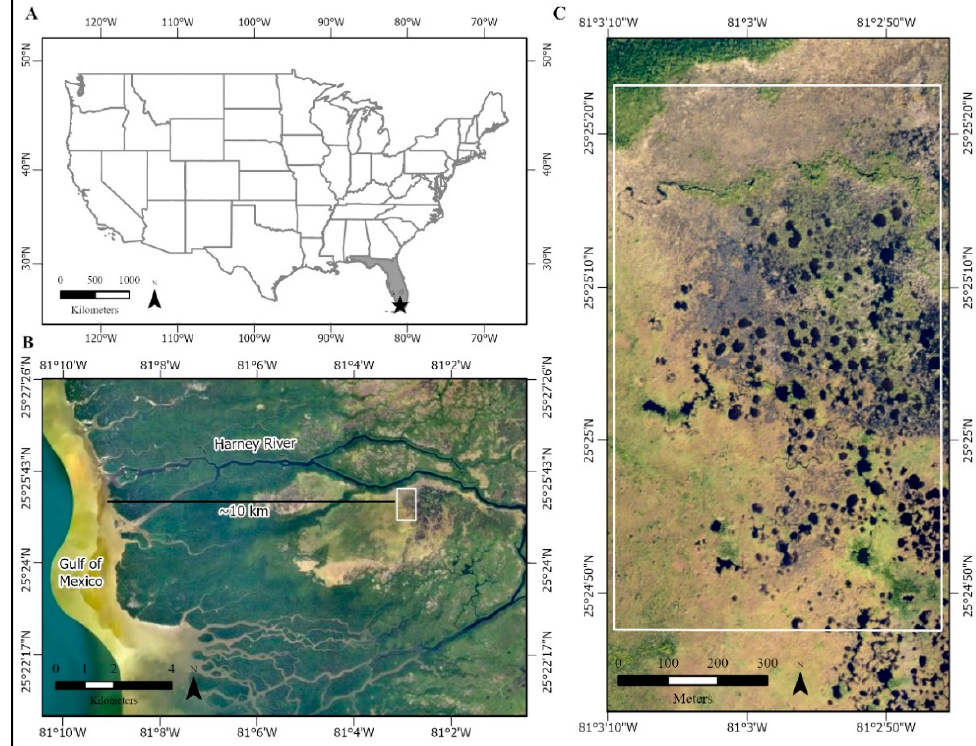
Figure 2. Overview of study area indicating the location of ( A ) the study area (black star) within the state of Florida (grey) in the United States; ( B ) the study area (white rectangle) and its position relative to the southwest coast of Florida with the distance (~10 km) to the Gulf of Mexico indicated; ( C ) the spatial extent (white box) of the study area. The aerial photography used an ArcGIS Pro (v.5.6) imagery base map obtained on 29 January